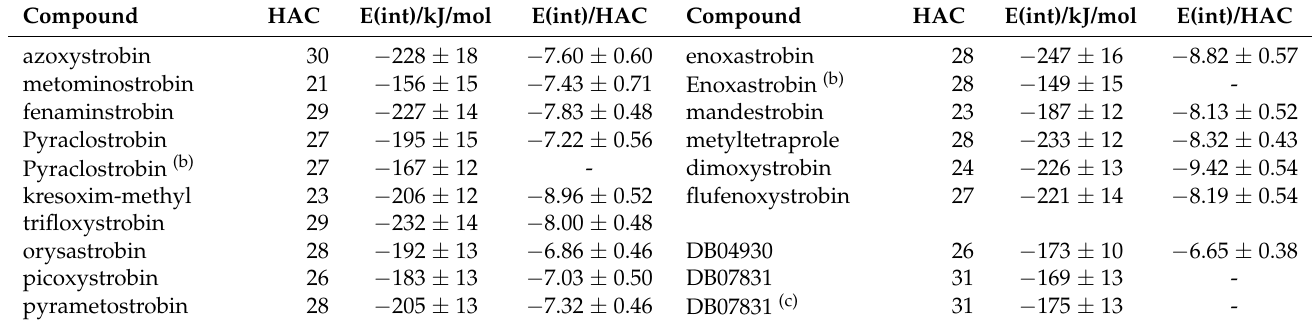
Table 3. Average interaction energy between ligand and protein through the whole MD (1 ns) trajectory. By default shown are compounds with SHB conformations (unless stated that it is about HSC (a) or rigidly docked conformation (b) ) Protein–ligand interaction energy (E(int)) is calculated following some guidelines in Ref. [16] (HAC denotes heavy atom